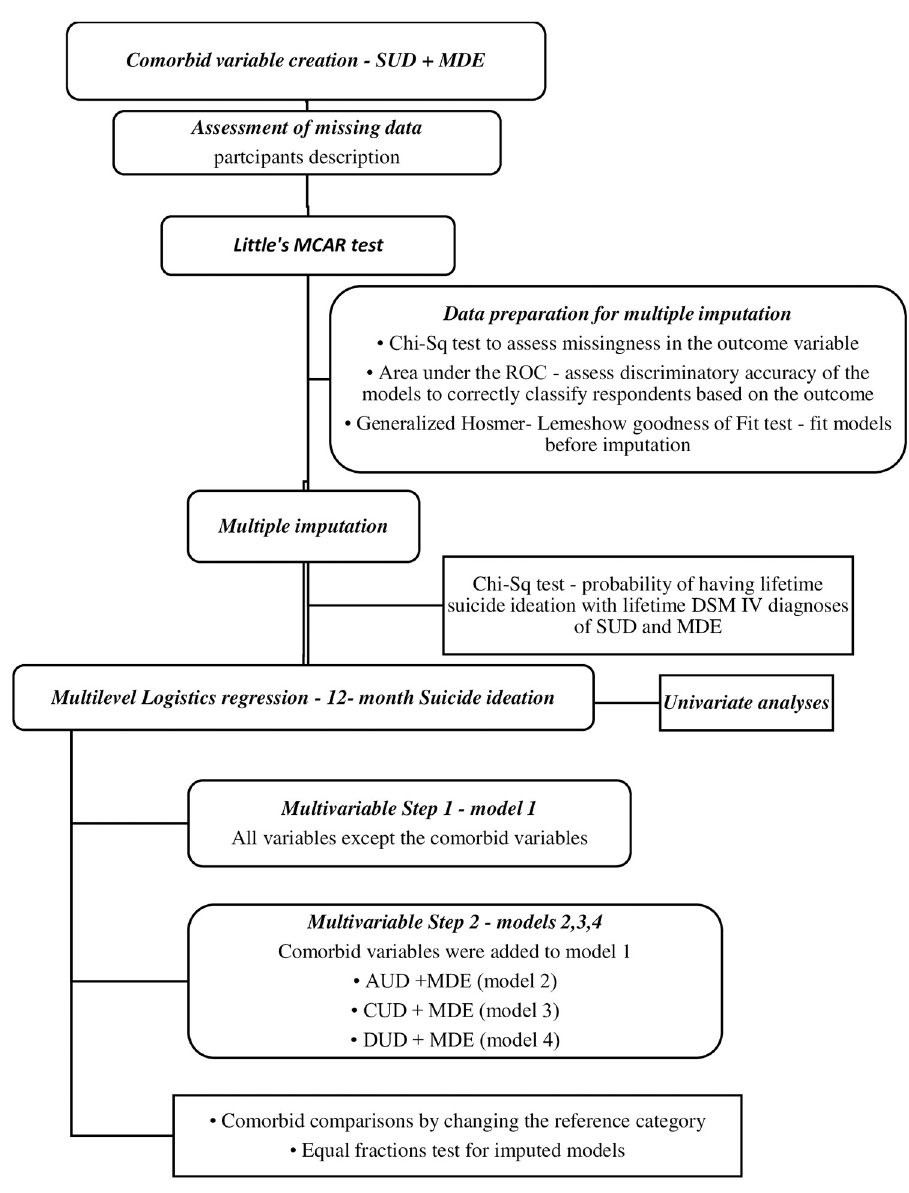
Fig 1. Statistical analysis flow chart lifetime DSM IV diagnoses and suicide ideation. SUD–Substance Use Disorder; MDE–Major Depressive Episode; MCAR–Missing Completely At Random; ROC–Receiver Operating Curve; DSM IV—Diagnostic and Statistical Manual of Mental Disorders IV; AUD–Alcohol Use Disorder; CUD– Cannabis Use Disorder; DUD–Drug Use Disorder (excluding cannabis); Chi-Sq–Chi